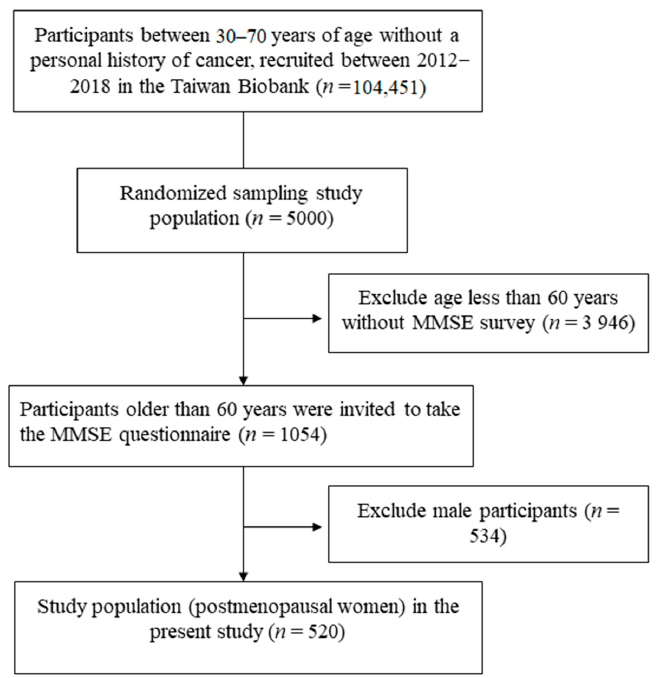
Figure 1. Flowchart of study population.